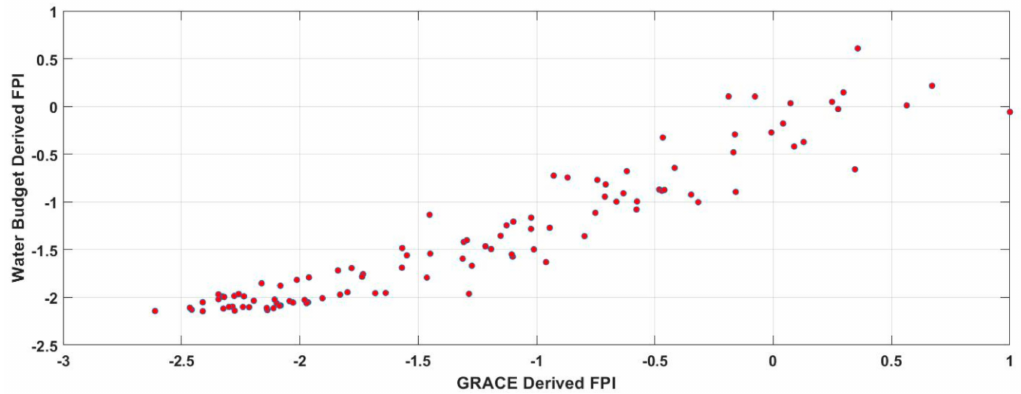
Figure 11. Scatterplot for GRACE-derived FPI and water budget-derived FPI .